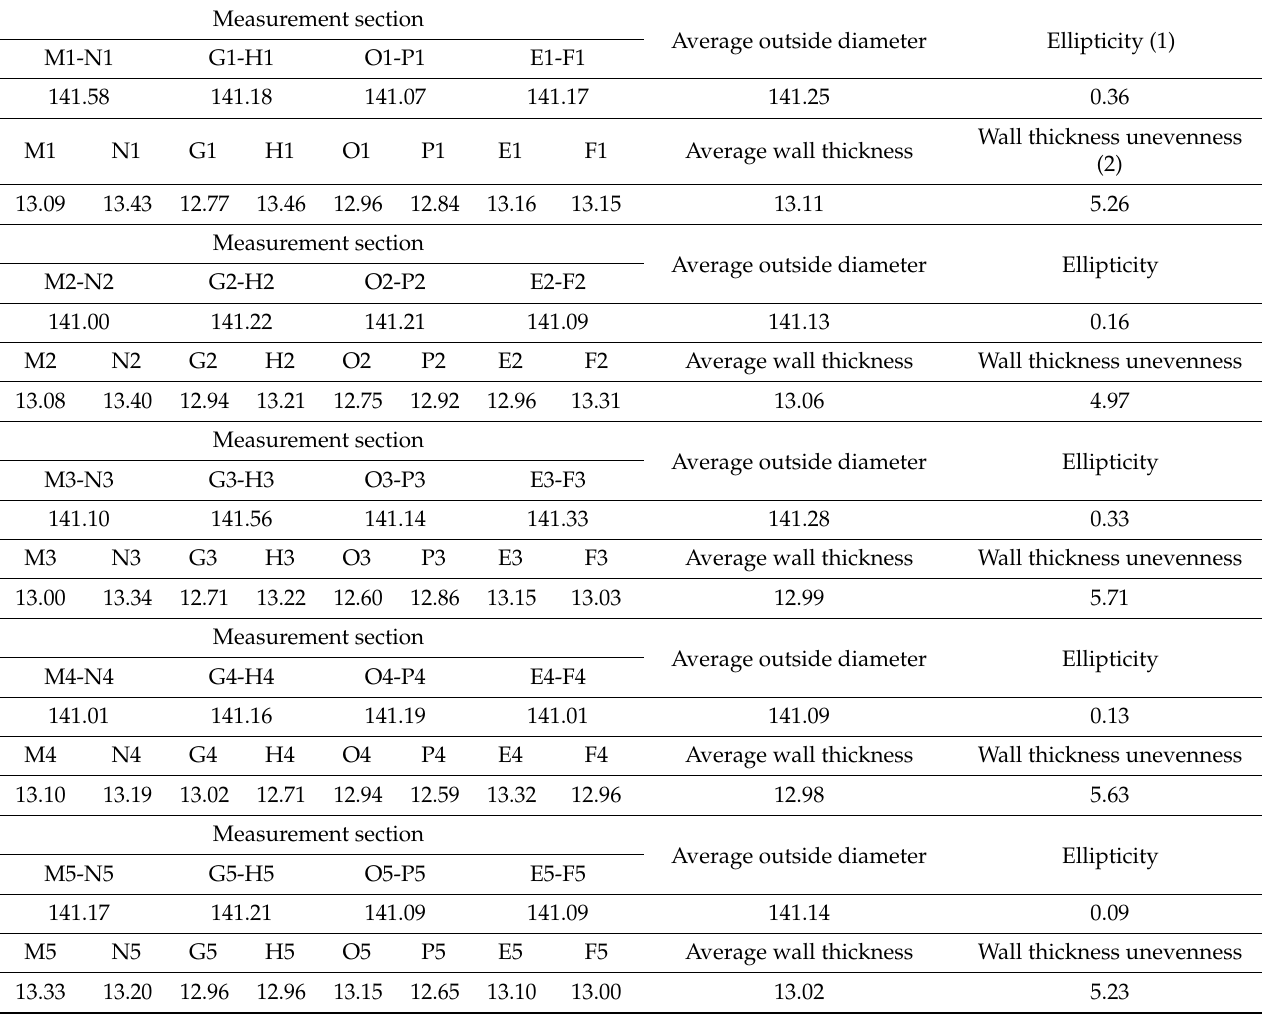
Figure 3. Measured specimen before collapse test. Note: 1 residual stress test specimen; 2 tensile specimens; 3 collapseed specimen. L 1 minimum length of the collapsed specimen. L 2 minimum length of residual stress specimen. Average outside diameter, average wall thickness, and ellipticity are measured at five equally spaced locations and the wall thickness unevenness is calculated from the wall thickness measurements. Table 1. Specimen geometry inspection results (mm).